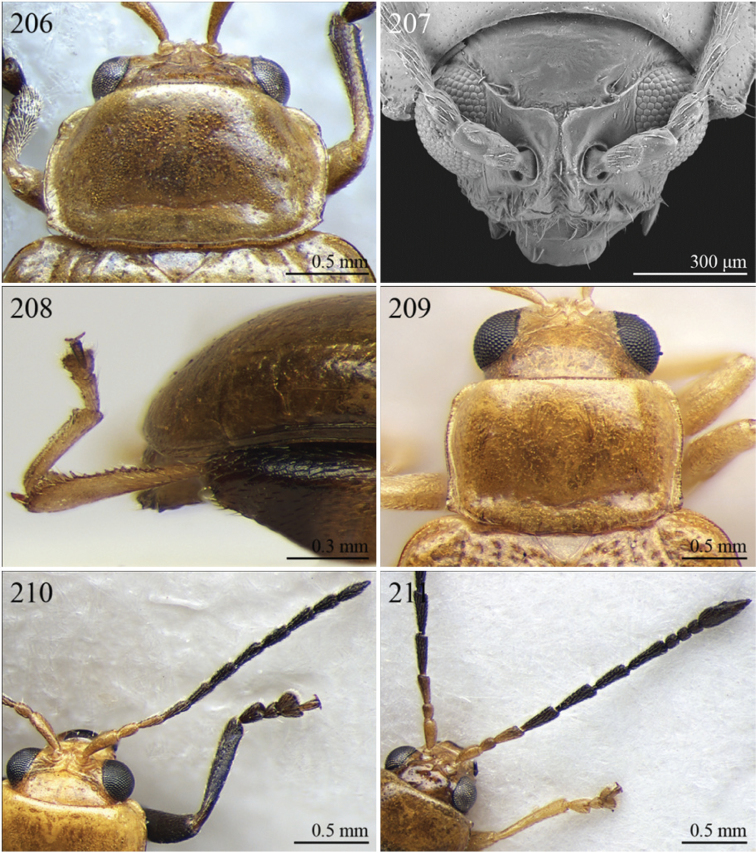
Morphological characters. 206
Lampedona testacea Bechyné, head and pronotum in dorsal view 207
Lepialtica bicolor Scherer, head in frontal view 208
Longitarsus africanus Jacoby, hind leg in lateral view 209
Lypnea flaveola (Bryant), head and pronotum in dorsal view 210
Lypnea costatipennis (Jacoby), head and right antenna in dorsal view 211
Malvernia varicornis Jacoby, head and right antenna in dorsal view.